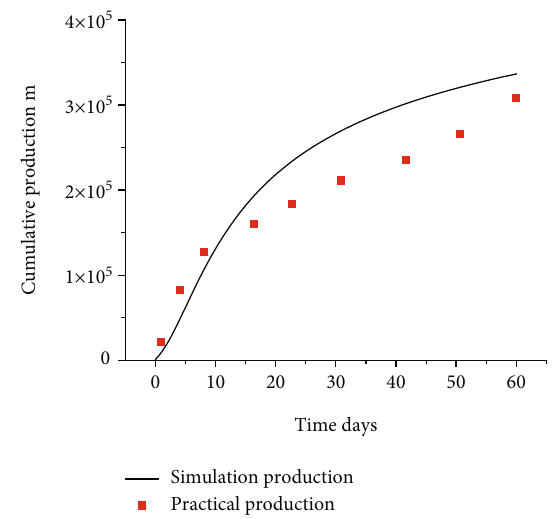
Figure 2: Simulation results of cumulative gas production compared with fi eld measured date from Shenhu pilot